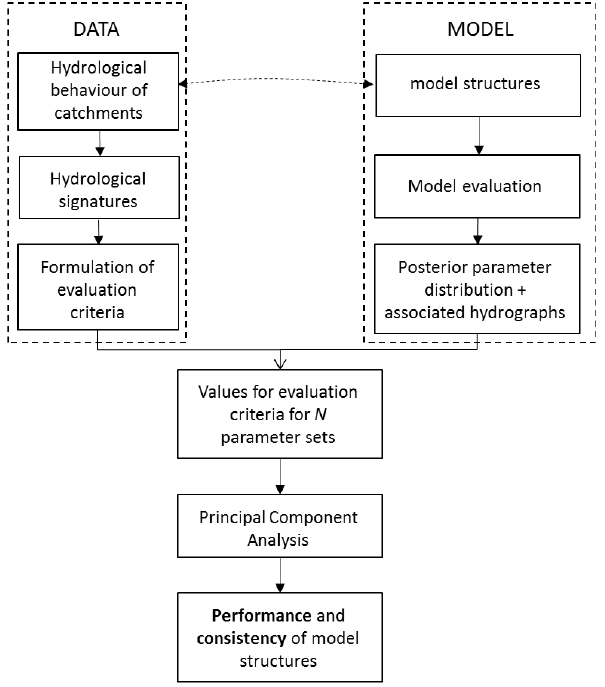
Fig. 1. Schematic overview of FARM to compare the performance and consistency of model structures with respect to hydrological